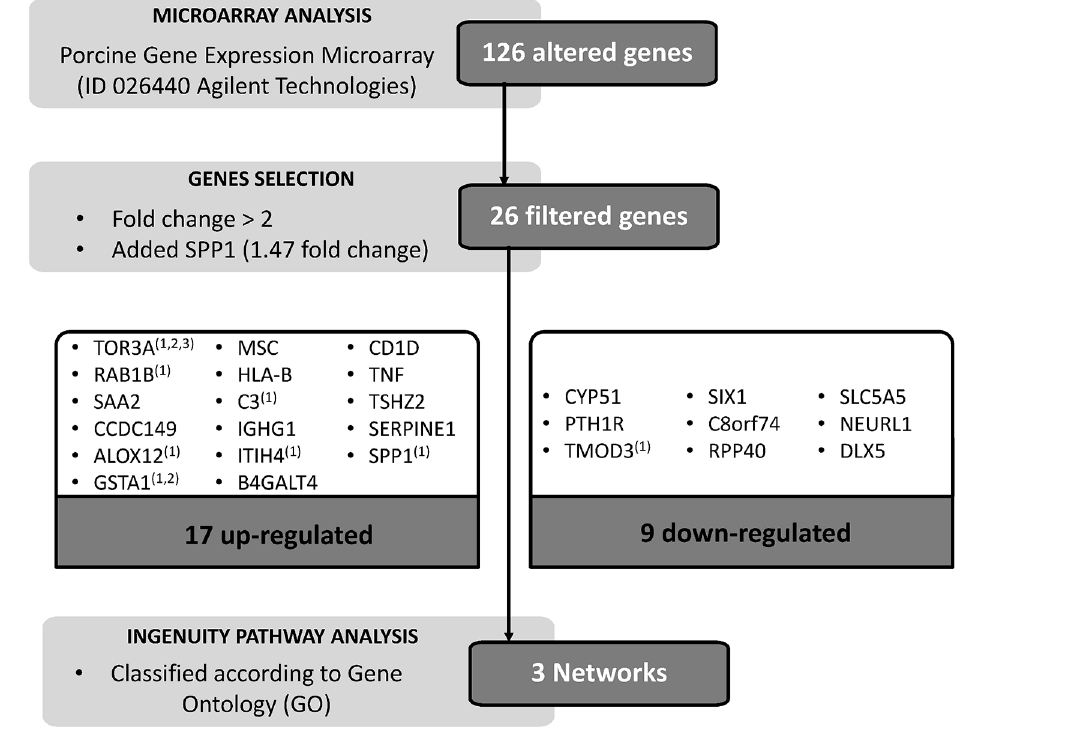
Fig 2. Scheme of the protocol followed to process and analysed the data obtained from array hybridization.